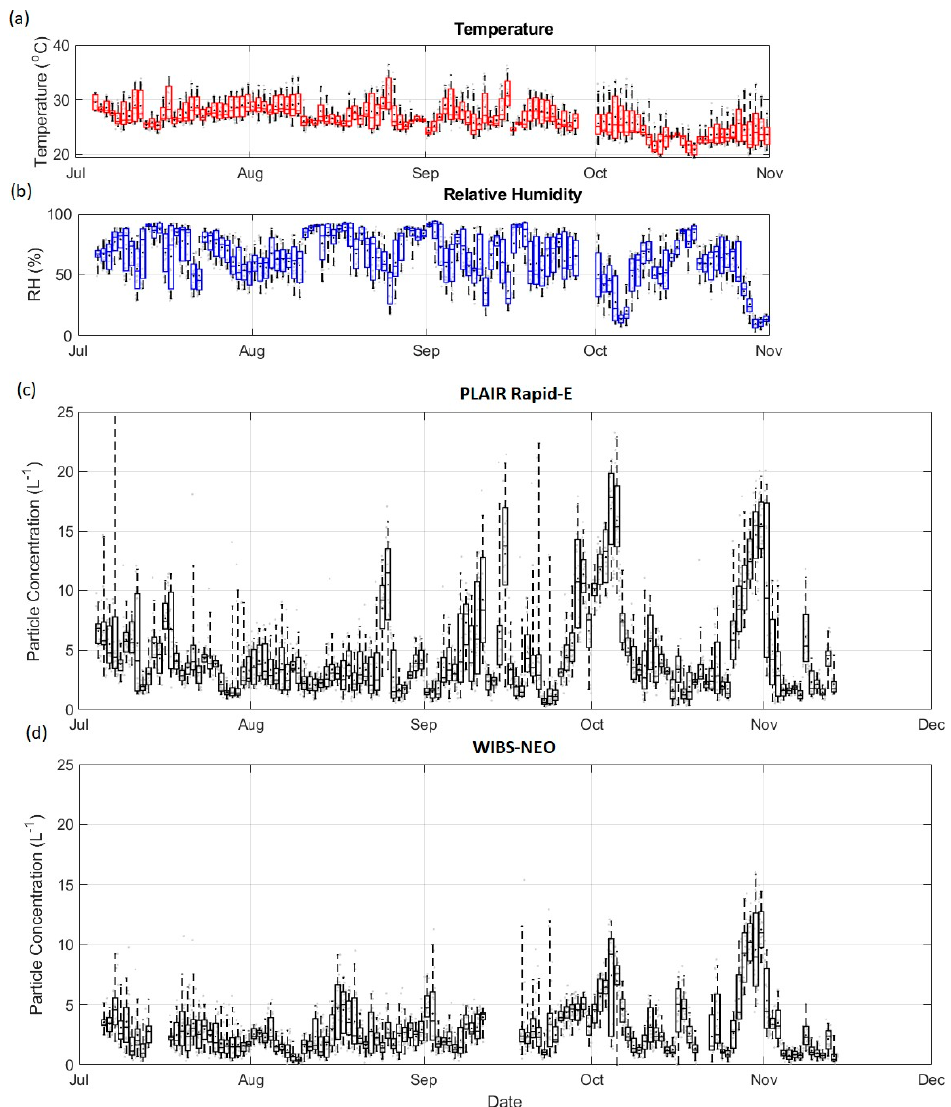
Figure 1. Time-series of the concentration of biofluorescent particles (L − 1 ) from July 5th to November 14th, as measured by the PLAIR Rapid-E and WIBS-NEO, shown in panels ( c ) and ( d ) respectively. Particles ≥ 5 µm were included for the PLAIR Rapid-E, while the WIBS-NEO recorded particles of 0.5–30 µm. Temperature and relative humidity from July 5th to November 1st are also shown in panels ( a ) and ( b ) respectively, recorded at the same sampling site. Whiskers represent 5th and 95th percentile values and the width of each box represents one day. Median values are denoted by a horizontal line and mean values by the black dot. Grey dots represent hourly averages.